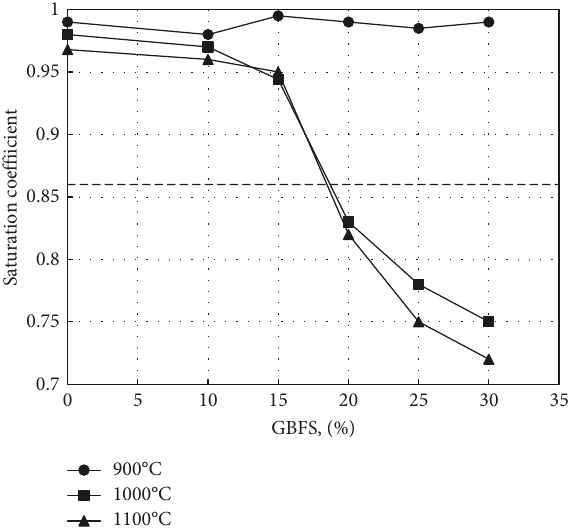
Figure 9: Effect of GBFS addition on saturation coefficient. (Dotted line corresponds to maximum value following ASTM C1167).